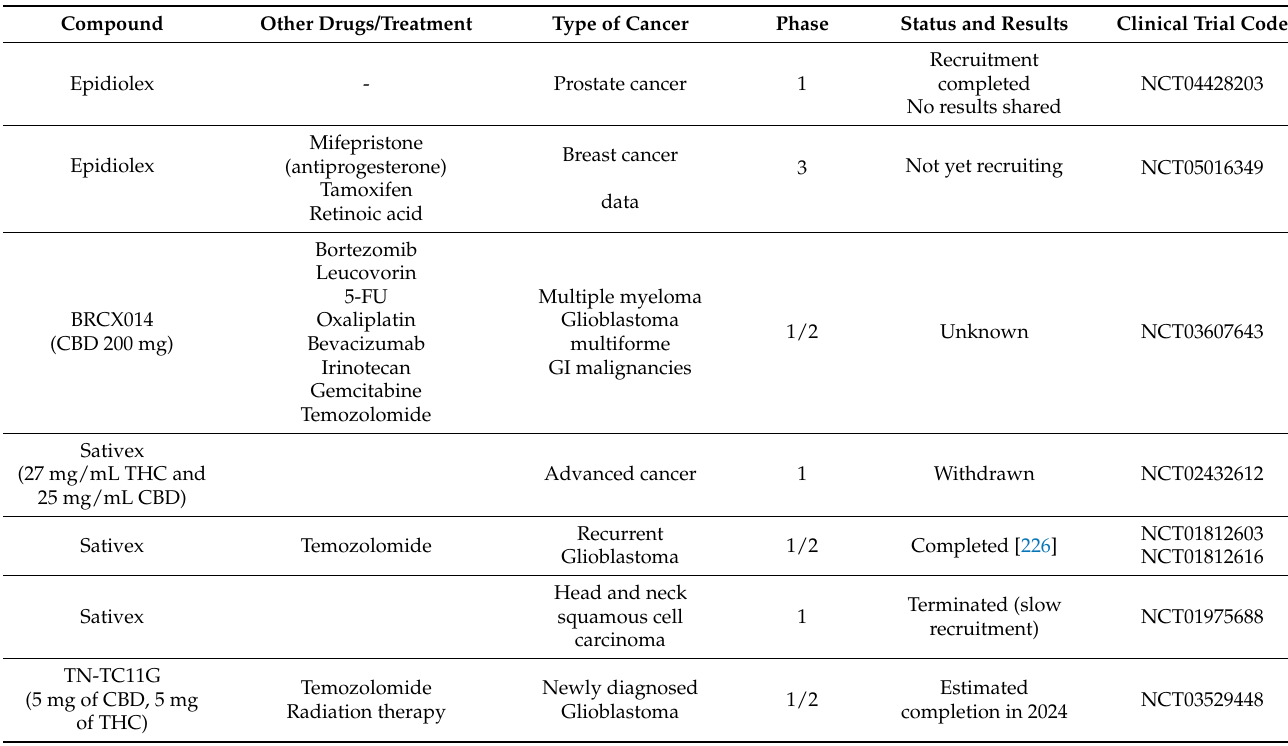
Table 4. List of clinical trials available at clinicaltrials.gov for the use of CBD as a cancer therapeutic